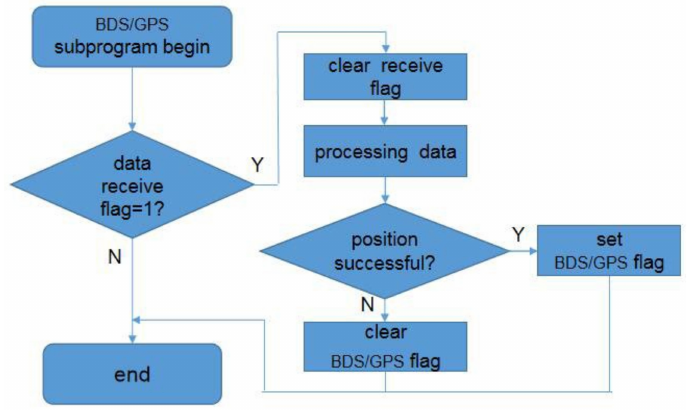
Figure 7. The flowchart of BDS/GPS